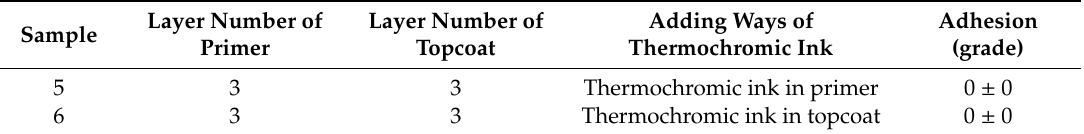
Table 10. Orthogonal experimental result of the influence of the coating process on the adhesion of coating.